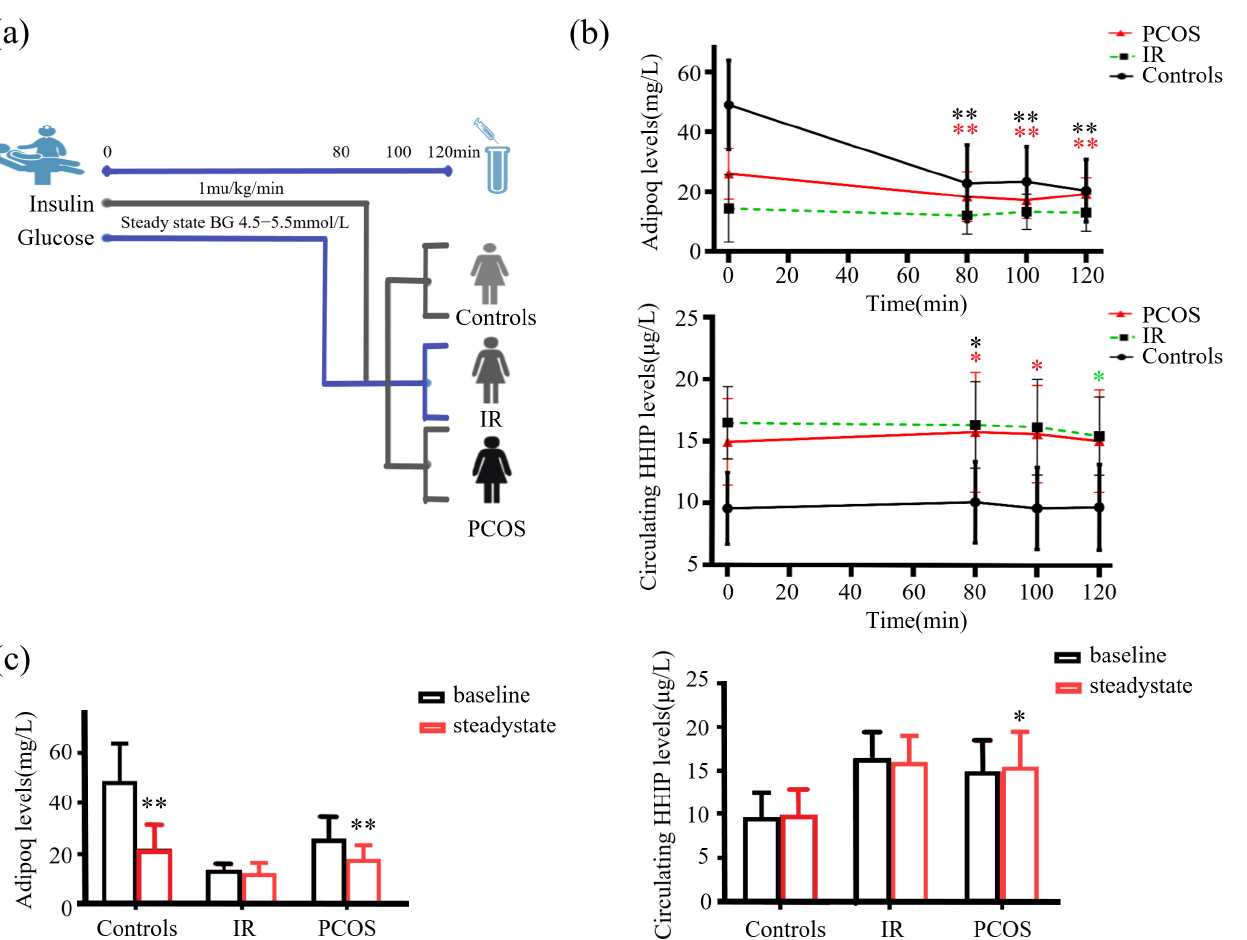
Figure 4. Serum HHIP levels in the study population during the EHC. ( a ) Experimental design for EHC. ( b ) Changes in Adipoq and HHIP levels during the EHC. ( c ) Cumulative Adipoq and HHIP levels during the EHC. Data are expressed as mean ± SD. * p < 0.05, ** p < 0.01 vs. baseline controls.